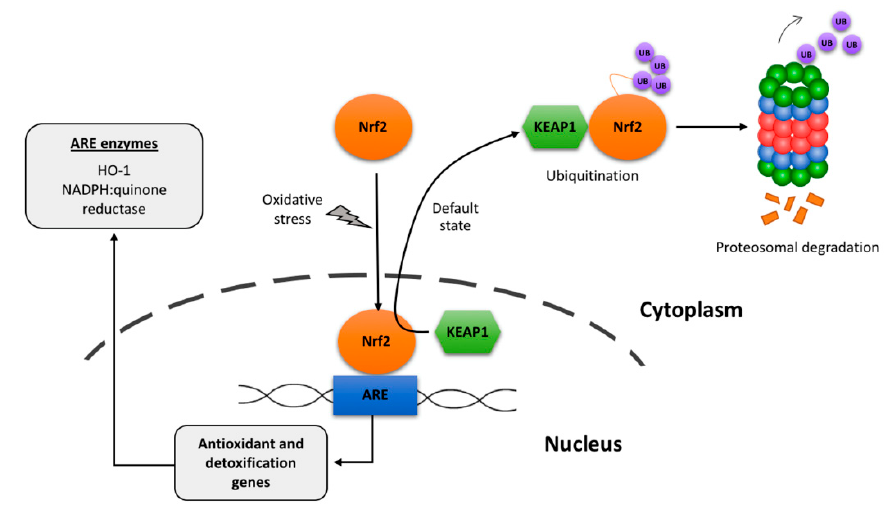
Figure 2. Scheme of default degradation and of oxidative-stress-induced activation of the transcription factor Nrf2. ARE: Antioxidant-response-element (components genes and proteins). It has been suggested that KEAP1/Nrf2 interaction occurs in the nucleus and then the complex is shuttled to the cytoplasm, however alternative mechanism may run in parallel (see